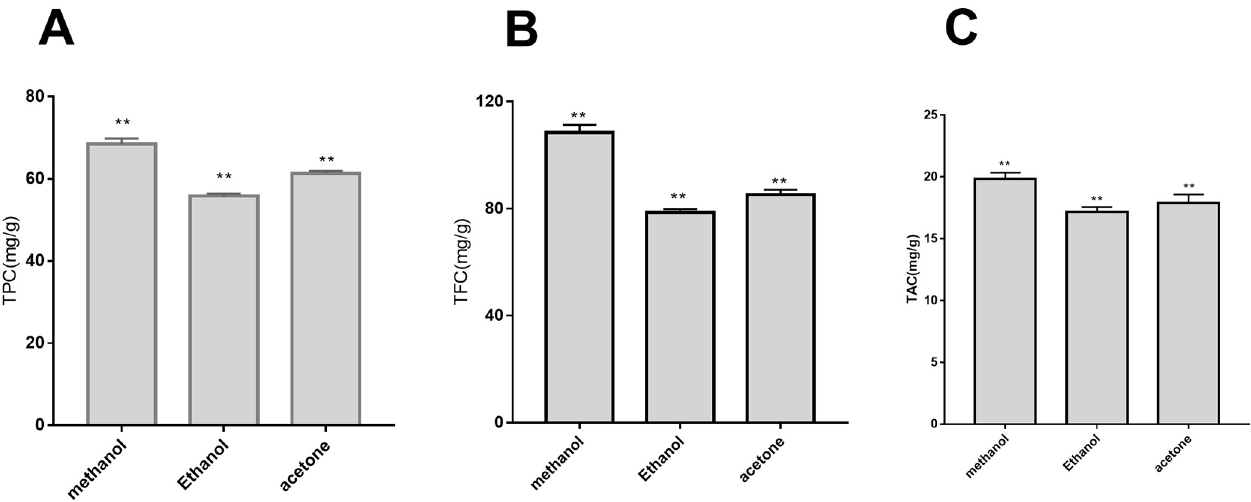
Fig 1. Quantification of TPC (A), TFC (B), and TAC (C) in Berberis heteropoda shrub extract. Comparison of the extraction effect of methanol, acetone, and ethanol. �� P < 0.05.